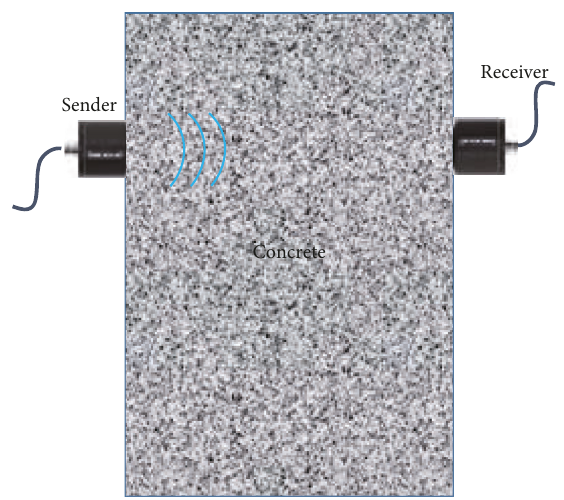
Figure 1: Schematic representation of